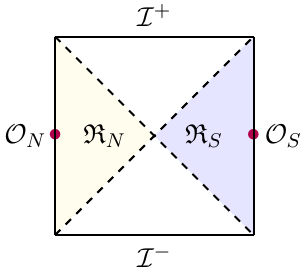
Figure 1 . Penrose diagram of dS 4 , with coordinates ( (cid:28); (cid:2)). In the conformal time (cid:28)